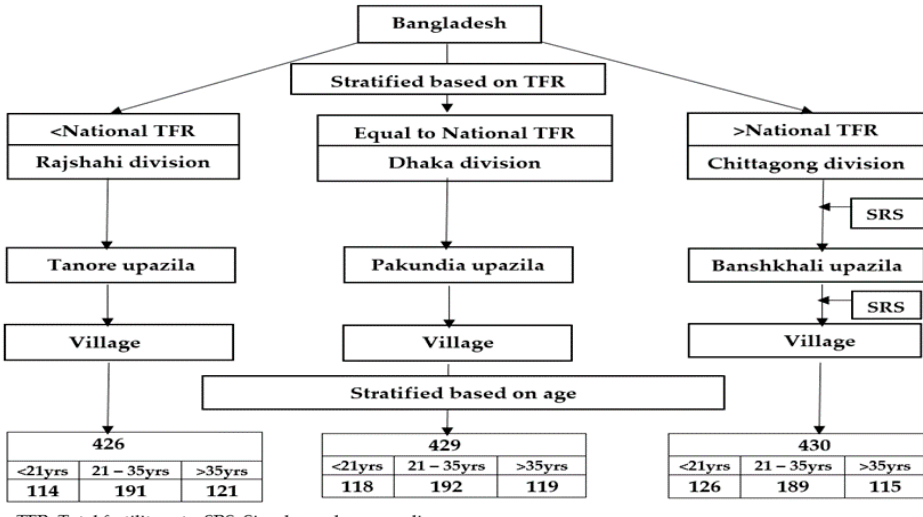
Figure 1. Multistage sampling.